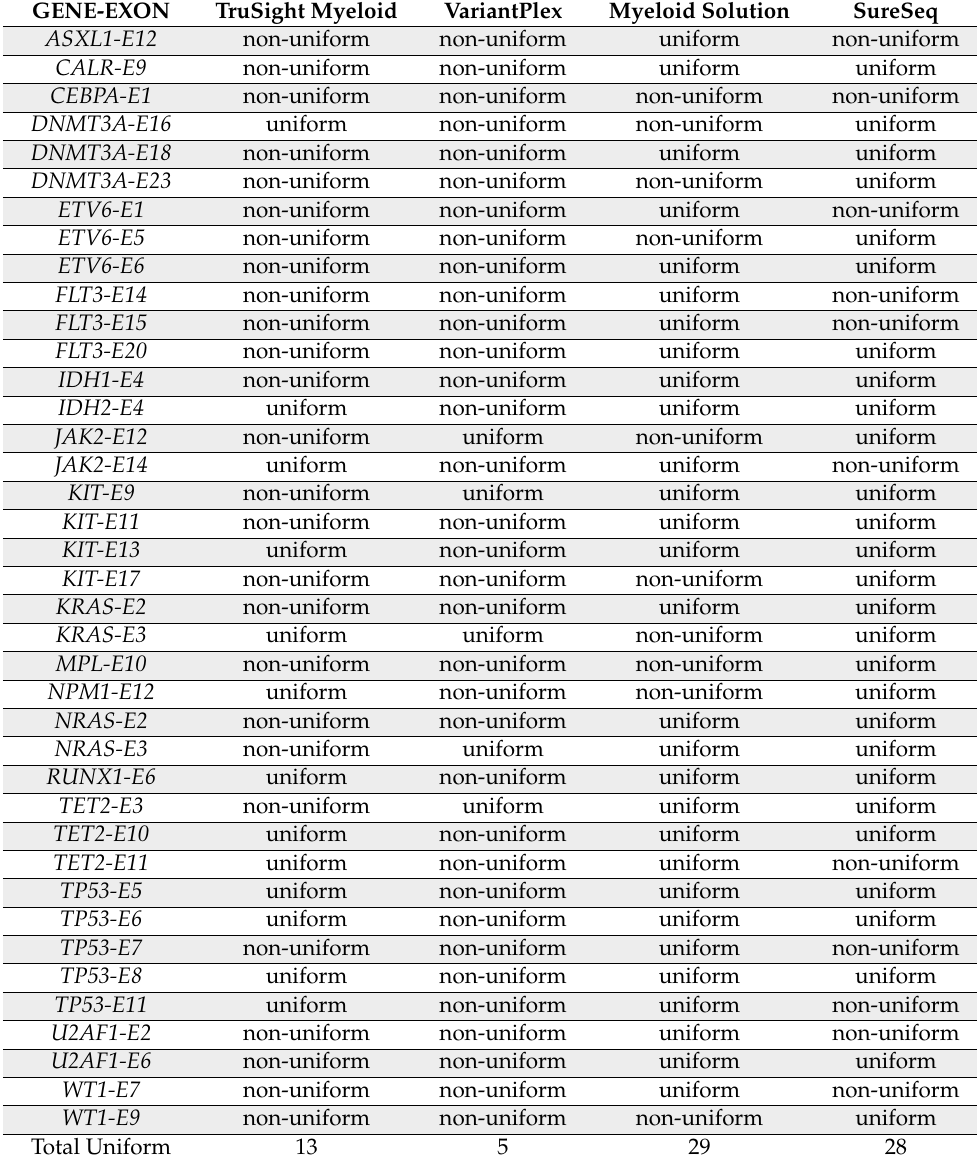
Table 3. Coverage uniformity of core myeloid gene (E =